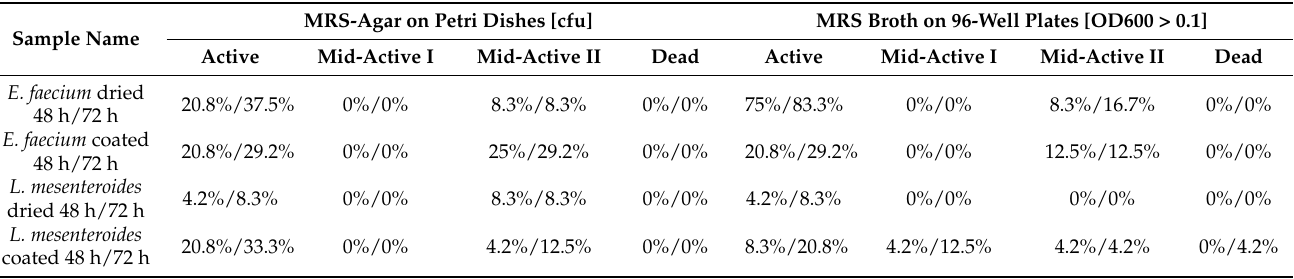
Table 2. Growth rates of bacterial cells after sorting on titration plates with solid medium and 96-well plates with liquid